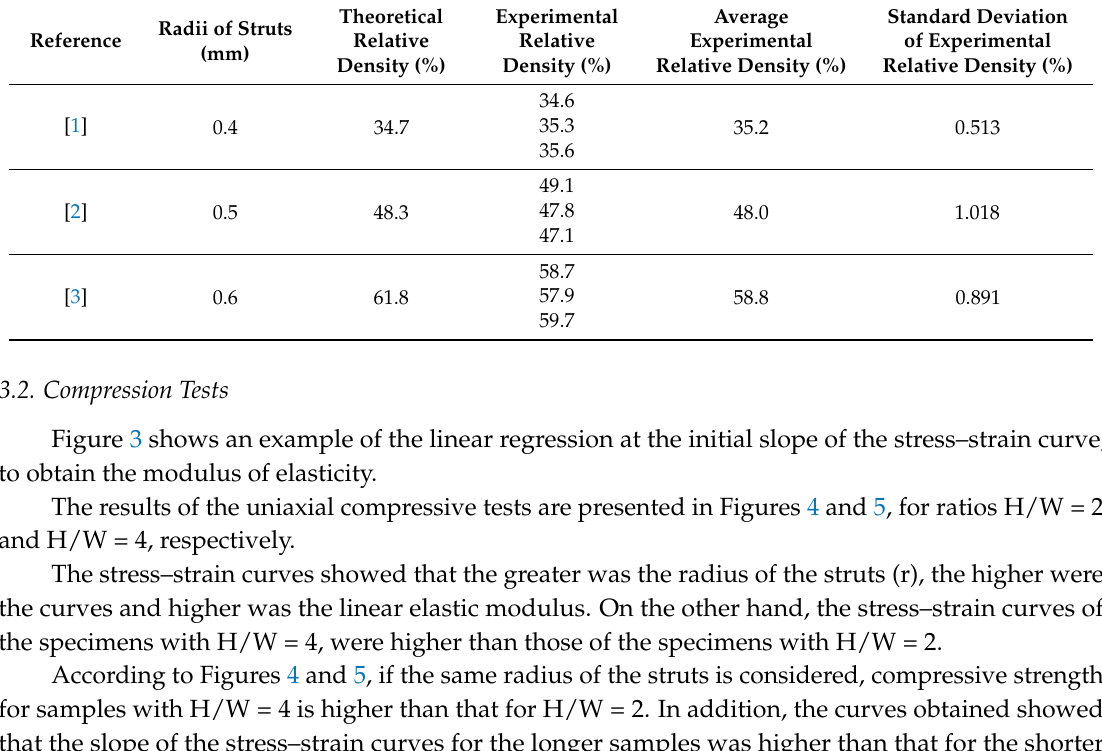
Table 1. Comparison between the theoretical and experimental relative density of the octet structure, for the different radii of the struts.